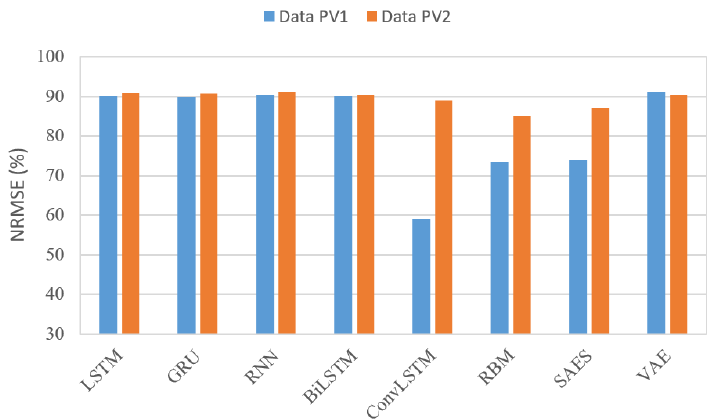
Figure 10. NRMSE by method based on the testing datasets from the two considered PV systems.